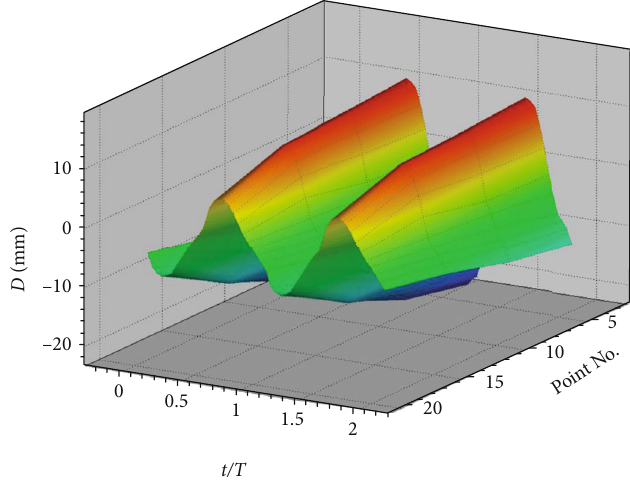
Figure 14: Deformation process of four points on the leading edge.